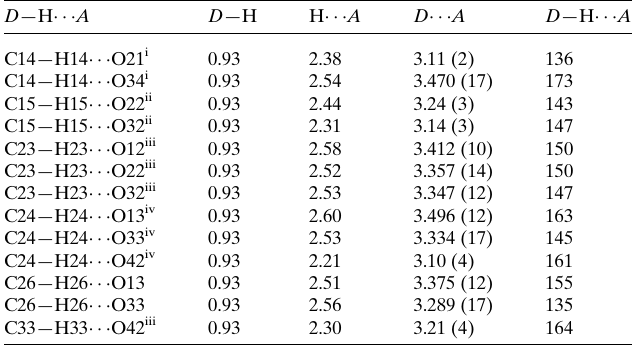
Table 1 Hydrogen-bond geometry (A˚ , (cid:3) ) for